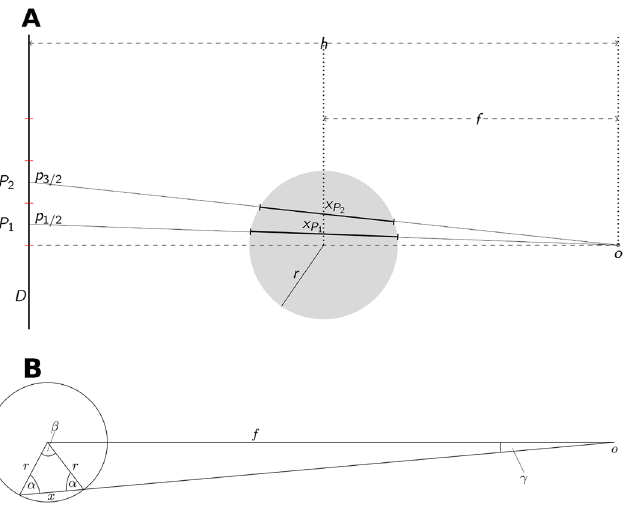
Figure 2. ( A ) Topview on the imaging geometry where the implant with radius r is exposed from the focal spot o on a detector D . The central x-ray is represented by the dashed line. Exemplarily the pixels P 1 , P 2 with dimension p and the respective distances x P 1 , x P 2 are indicated. Their centers are found at p 1 / 2 , p 3 / 2 . ( B ) Distances and angles within the implant-cross-section used for calculation of the the x-ray-paths through the